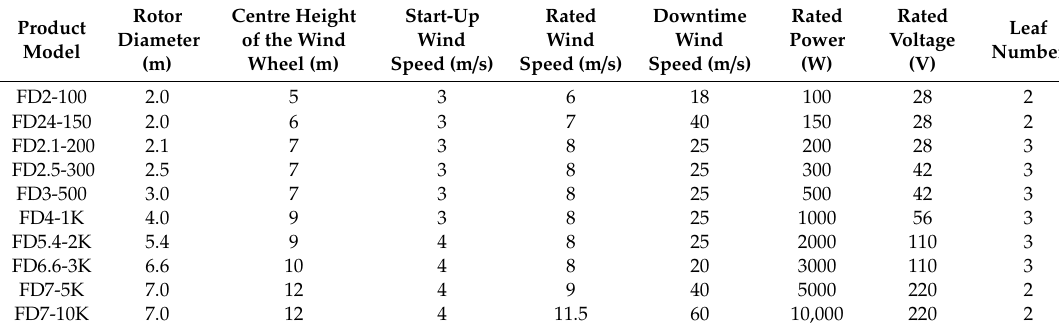
Table 5. Part of parameters for small-scale wind